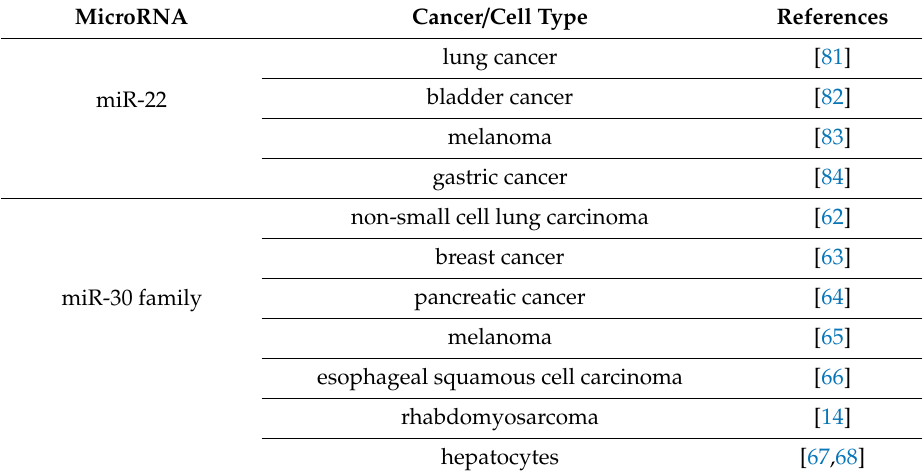
Table 1. MicroRNAs regulating